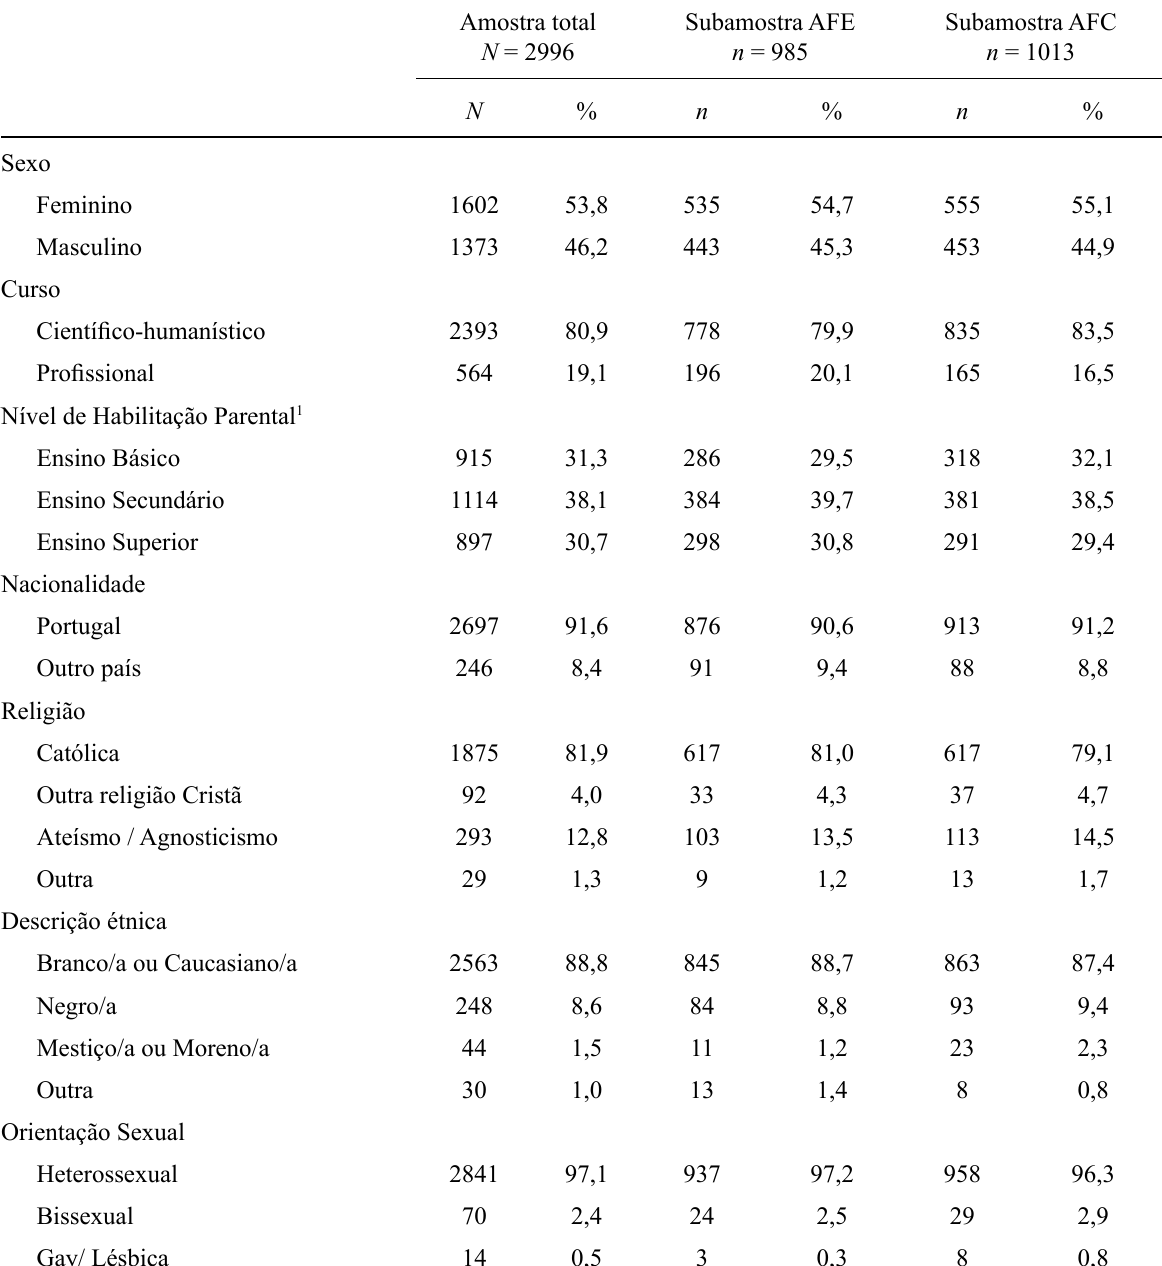
Descrição Sociodemográ fi ca dos Participantes do Estudo: Amostra Total, Amostra AEF e Amostra